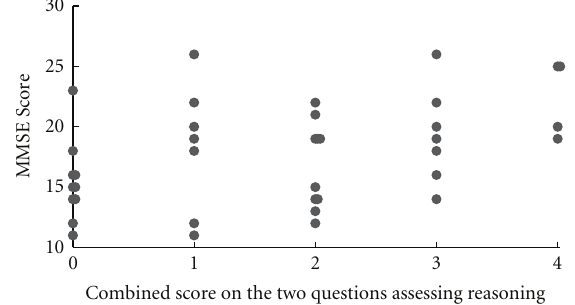
Figure 3: Relation of scores on the Mini-Mental State Exam to scores on questions assessing reasoning ( r = 0 . 41, P = 0 .